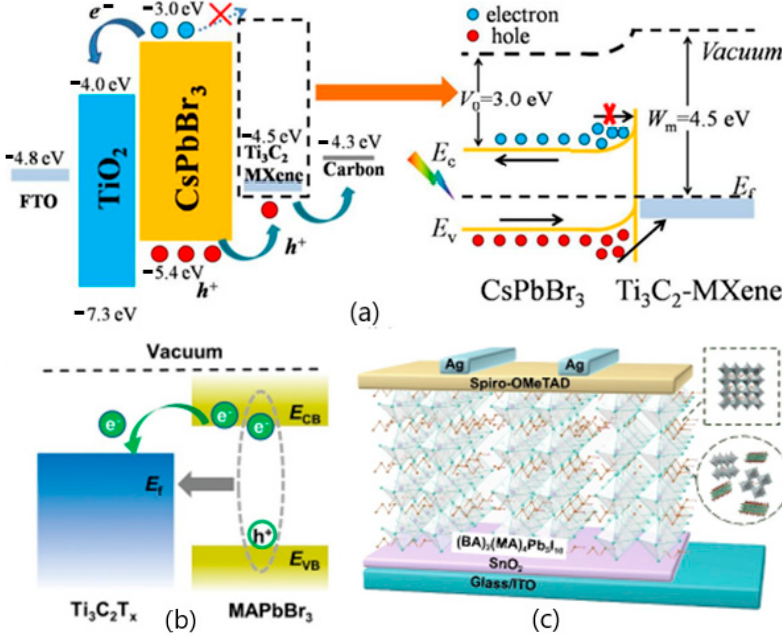
Figure 4. ( a ) The device’s energy bandgap and carrier transport mechanism under illumination at the interface, respectively. Reprinted with permission from Ref. [21]. 2019, Royal Society of Chem- istry. ( b ) Energy transfer scheme between MXene and perovskite nanoflakes. Reprinted with per- mission from Ref. [29] 2021, Springer Nature. ( c ) The schematic diagram of the device. Reprinted with permission from Ref. [30]. 2020, John Wiley and Sons.